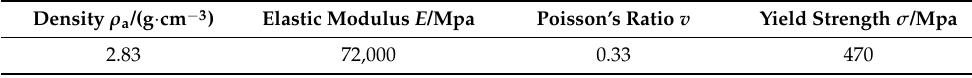
Figure 6. Finite element model of the CFRP-Al hybrid circular tube. Table 6. Mechanical property parameters of Al alloy.